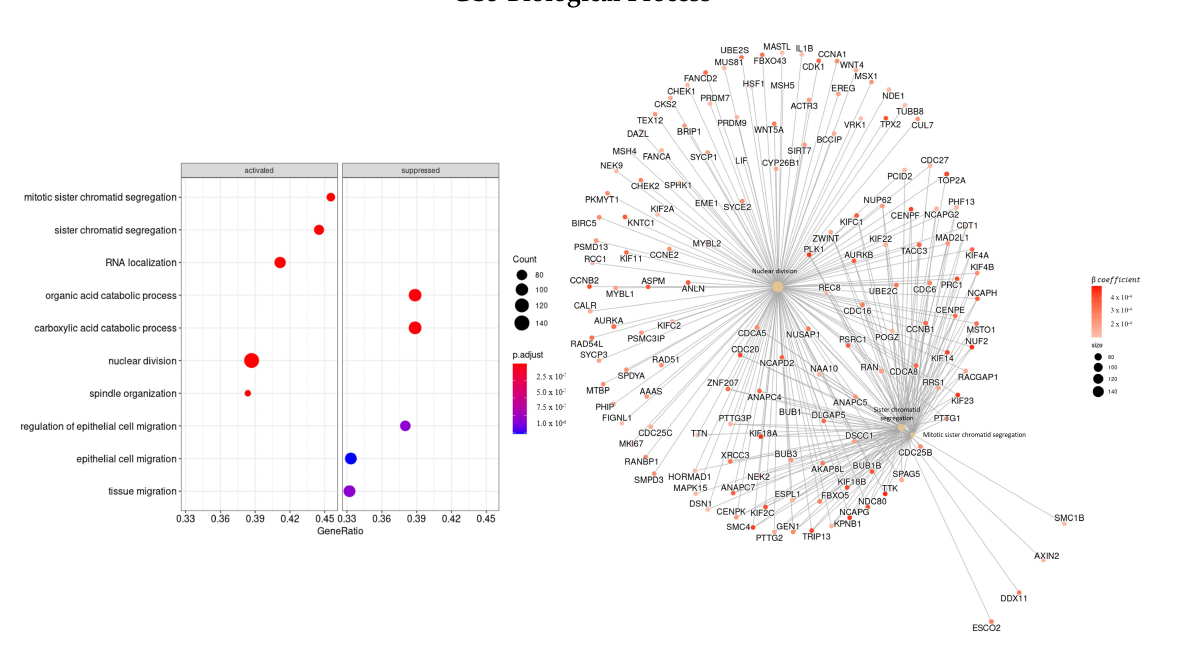
Figure 7. Gene ontology enrichment analysis regarding biological processes terms for a list of genes selected by EN ranked by the β coefficients of the regression. The left panel shows a dot chart with the most significant BP terms and on the right a gene-concept network plot of the three most enriched terms depicts the linkages of genes and biological concepts as a network.